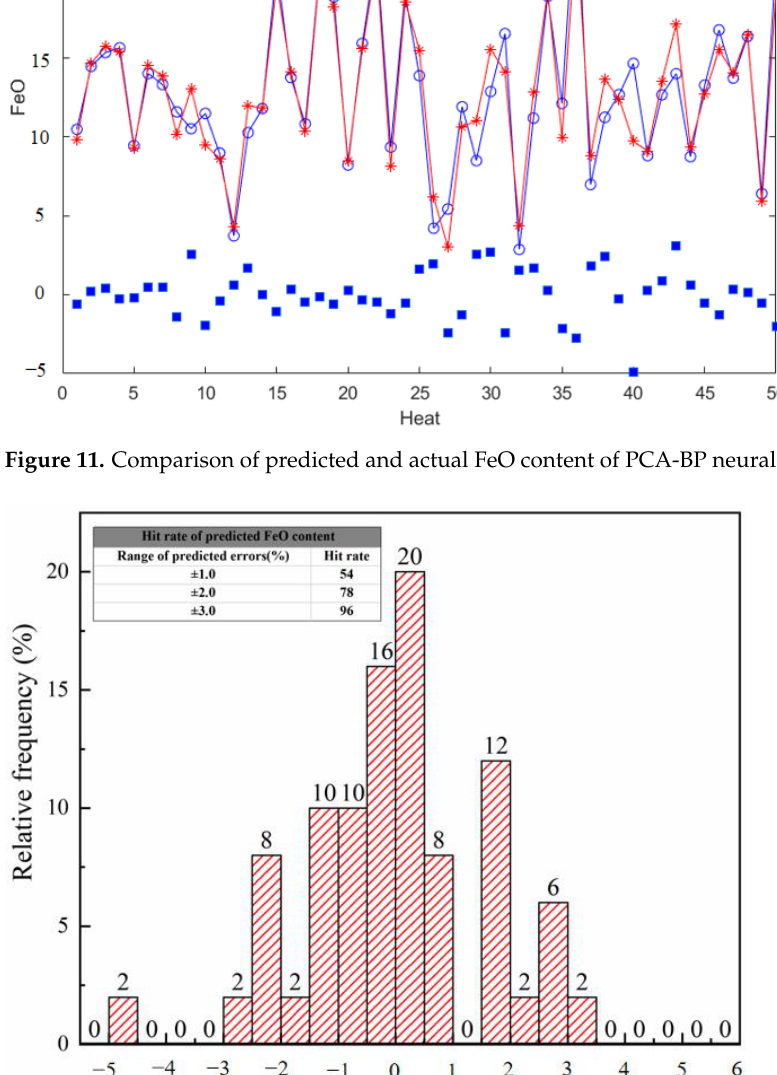
Table 8. Comparison of accuracy and error of three prediction models.